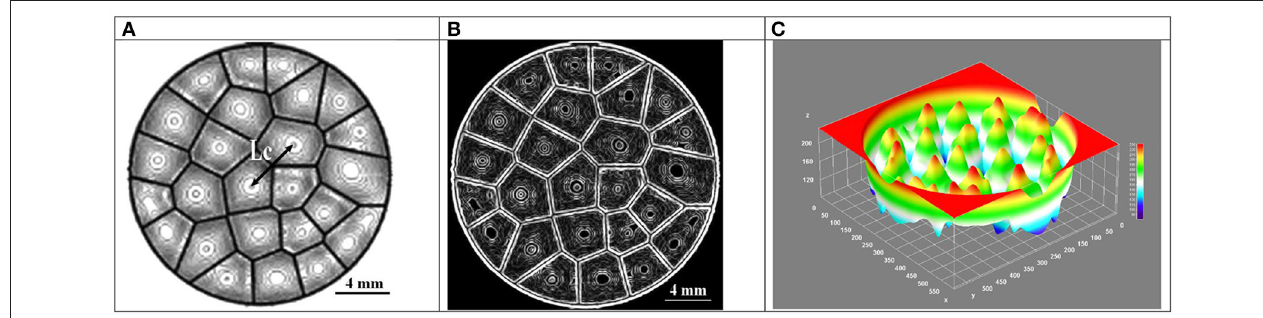
FIGURE 7 | (A) Circulation cells in silicone oil layer ( d = 2.1mm) heated from below 1 T = 2.5K, L c = 2.3 × d = 4.9mm. (B) “Find Edges” procedure (ImageJ program) applied to the picture. (C) 3D thermograph of liquid temperature distribution after onset of B-M circulation. Cooler and wormer regions are indicated with blue and red colors, respectively. When the pattern is fully developed, it becomes an almost perfect array of regular hexagons, arranged in a honeycomb.